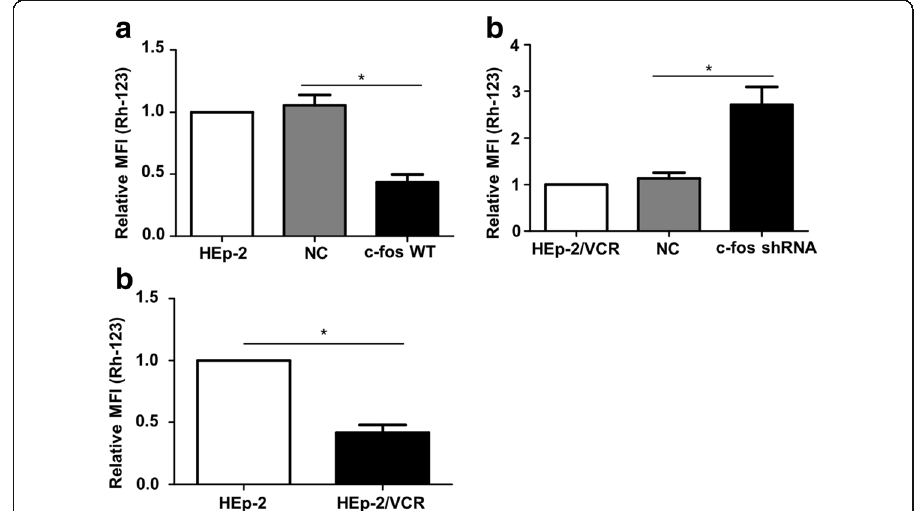
Fig. 5 Effect of c-fos expression on the efflux function of P-gp. Cells were incubated with Rh-123 for 60 min, and then MFI (Rh-123) was determined using flow cytometric analysis. a The intracellular MFI was markedly lower in the c-fos WT group than in the NC group. b The intracellular MFI was significantly higher in the c-fos shRNA group than in the NC group. c The intracellular MFI (Rh-123) values for HEp-2/VCR cells and HEp-2 cells. Data are shown as the means ±SD. * p